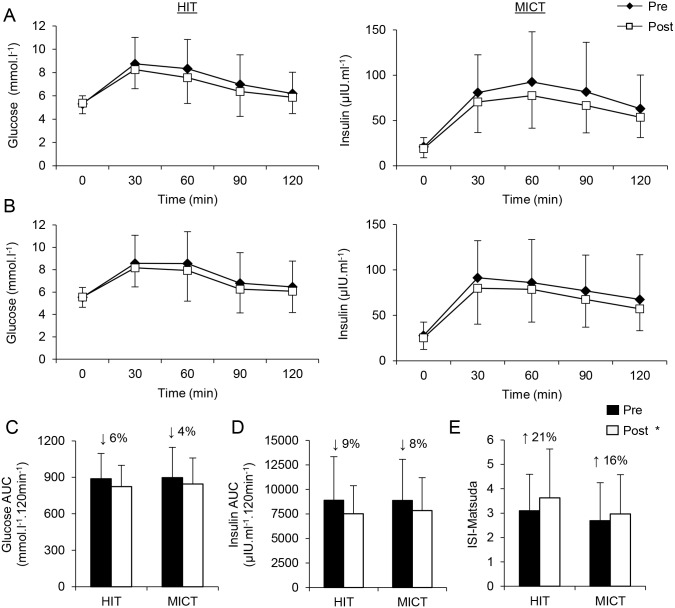
Oral glucose tolerance test responses.Plasma glucose (A) and insulin (B) concentrations during an oral glucose tolerance test, including corresponding total area under the curve (AUC, C and D, respectively) before and after HIT or MICT. Changes in insulin sensitivity as determined using the Matsuda insulin sensitivity index in response to HIT and MICT (E). Values are presented as means ± SD. *Main training effect (p<0.05). Values in parentheses represent the mean percentage change from pre-training.